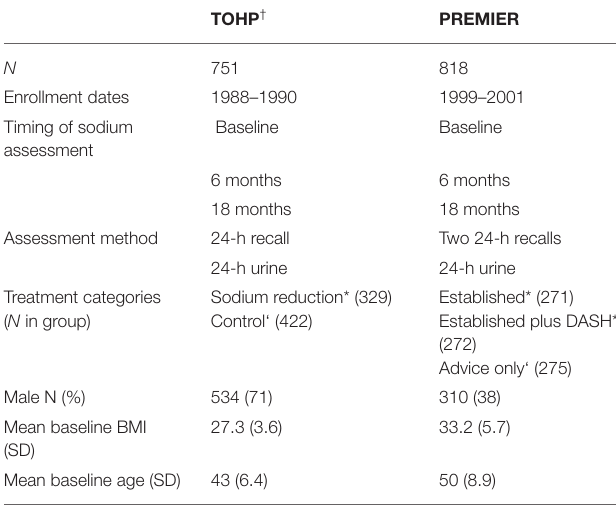
TABLE 1 | Study characteristics and participant demographics in TOPH and PREMIER